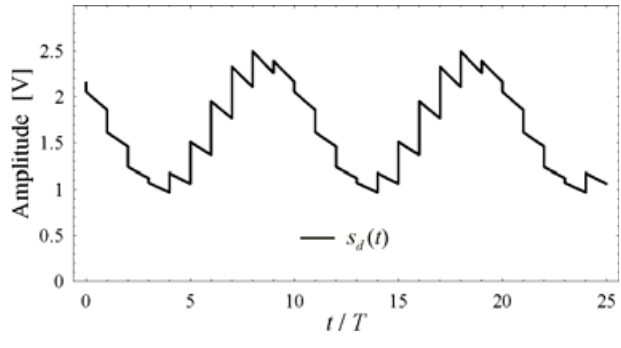
FIG. 7. Difference of the signals in Fig. 6.